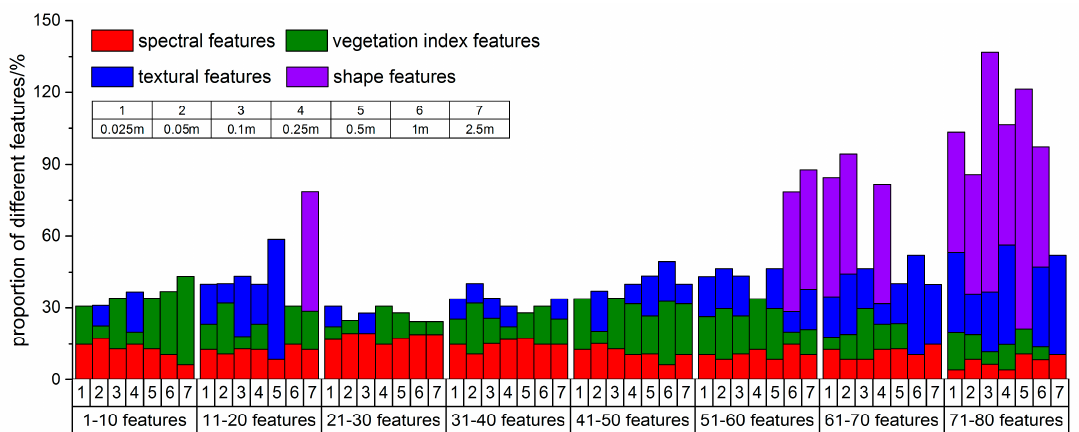
Figure 5. Distribution of feature types within feature groups in multi-scale images.